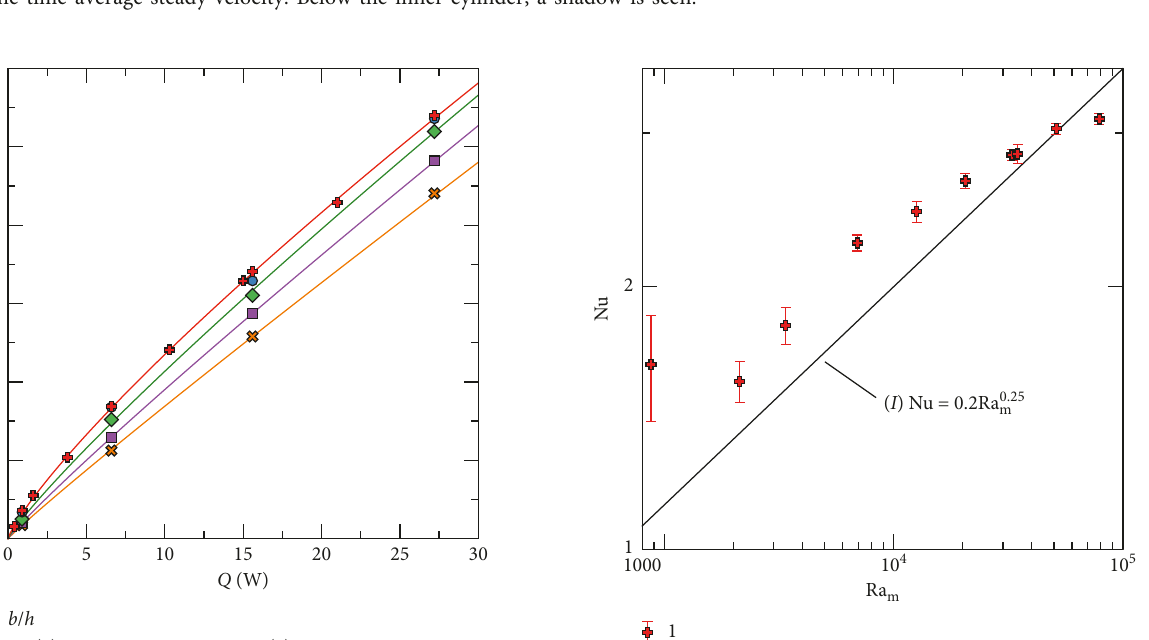
Figure 2: Vector plots of steady-flow velocity fields at the heating power Q � 27 . 2 W in the absence of vibrations (a) and at vibrations with the frequency f � 3 . 00 Hz and the amplitude b � 10 . 2 mm ( b / h � 0 . 58). (b) The colour maps represent vorticity calculated from the vector field of the time-average steady velocity. Below the inner cylinder, a shadow is seen.